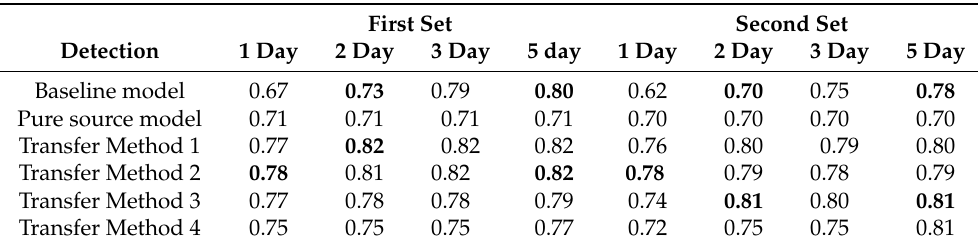
Table 3. Different model MCC score of occupancy detection with regards to the length of training data. First Set Second Set